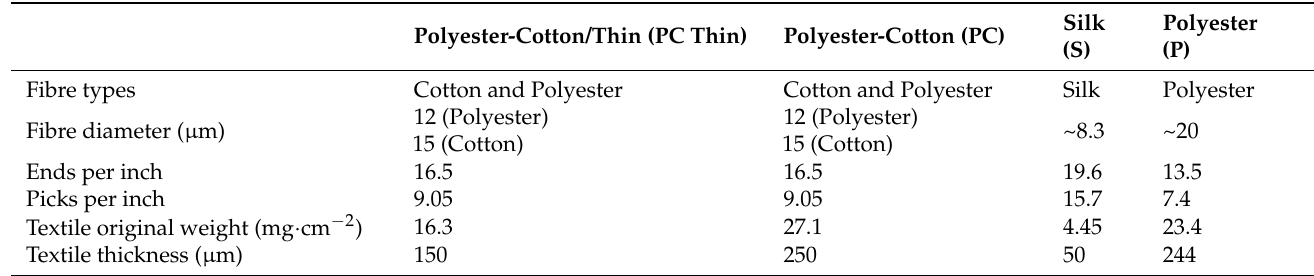
Table 1. Characteristics of the textile substrates used throughout this study. Polyester-Cotton/Thin (PC Thin) Polyester-Cotton (PC)